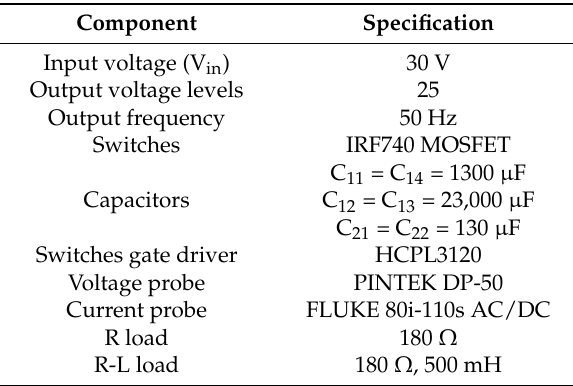
Table 4. Laboratory setup specifications.